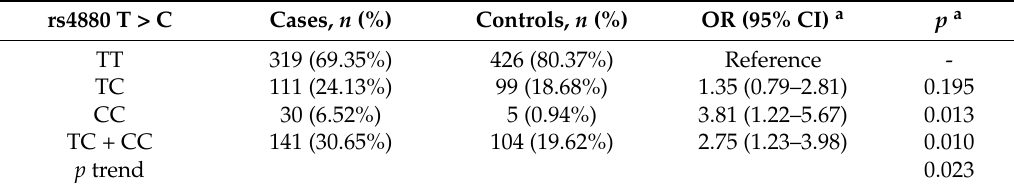
Table 2. Genotype frequencies of SOD2 rs4880 polymorphism in PAH cases and controls.